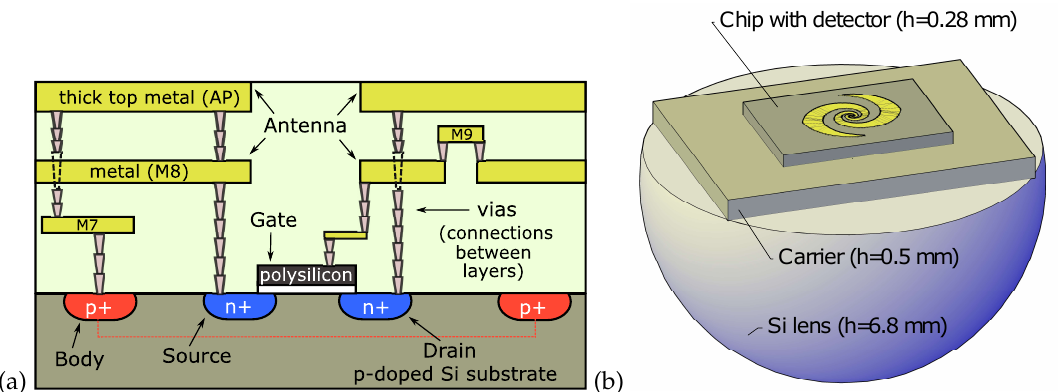
Figure 1. ( a ) Schematic cross-sectional view of the detector chip (not to scale); ( b ) Device with the monolithically integrated log-spiral antenna mounted on a carrier substrate and placed on a hyper-hemispherical lens (diameter of the spherical part of the lens: 12 mm).